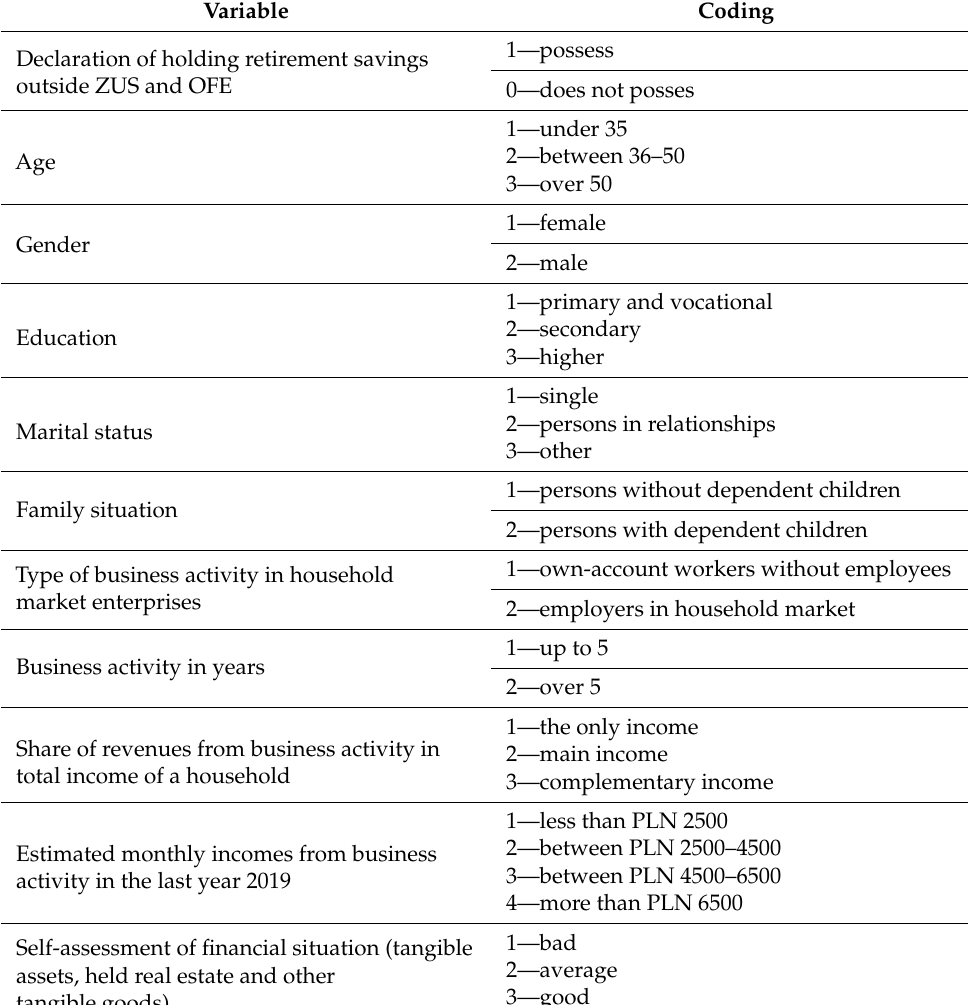
Table 5. Variables introduced into the model and coding